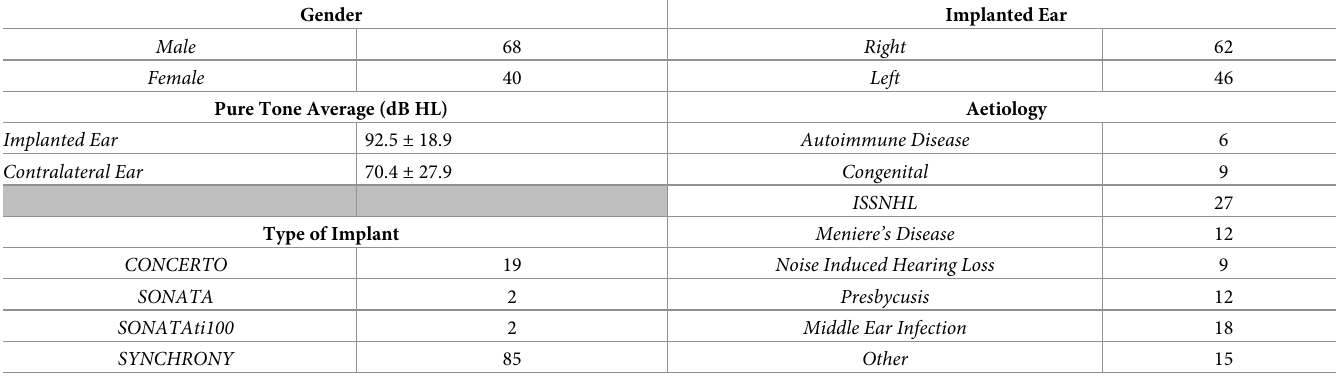
Table 1. Participant demographics and clinical